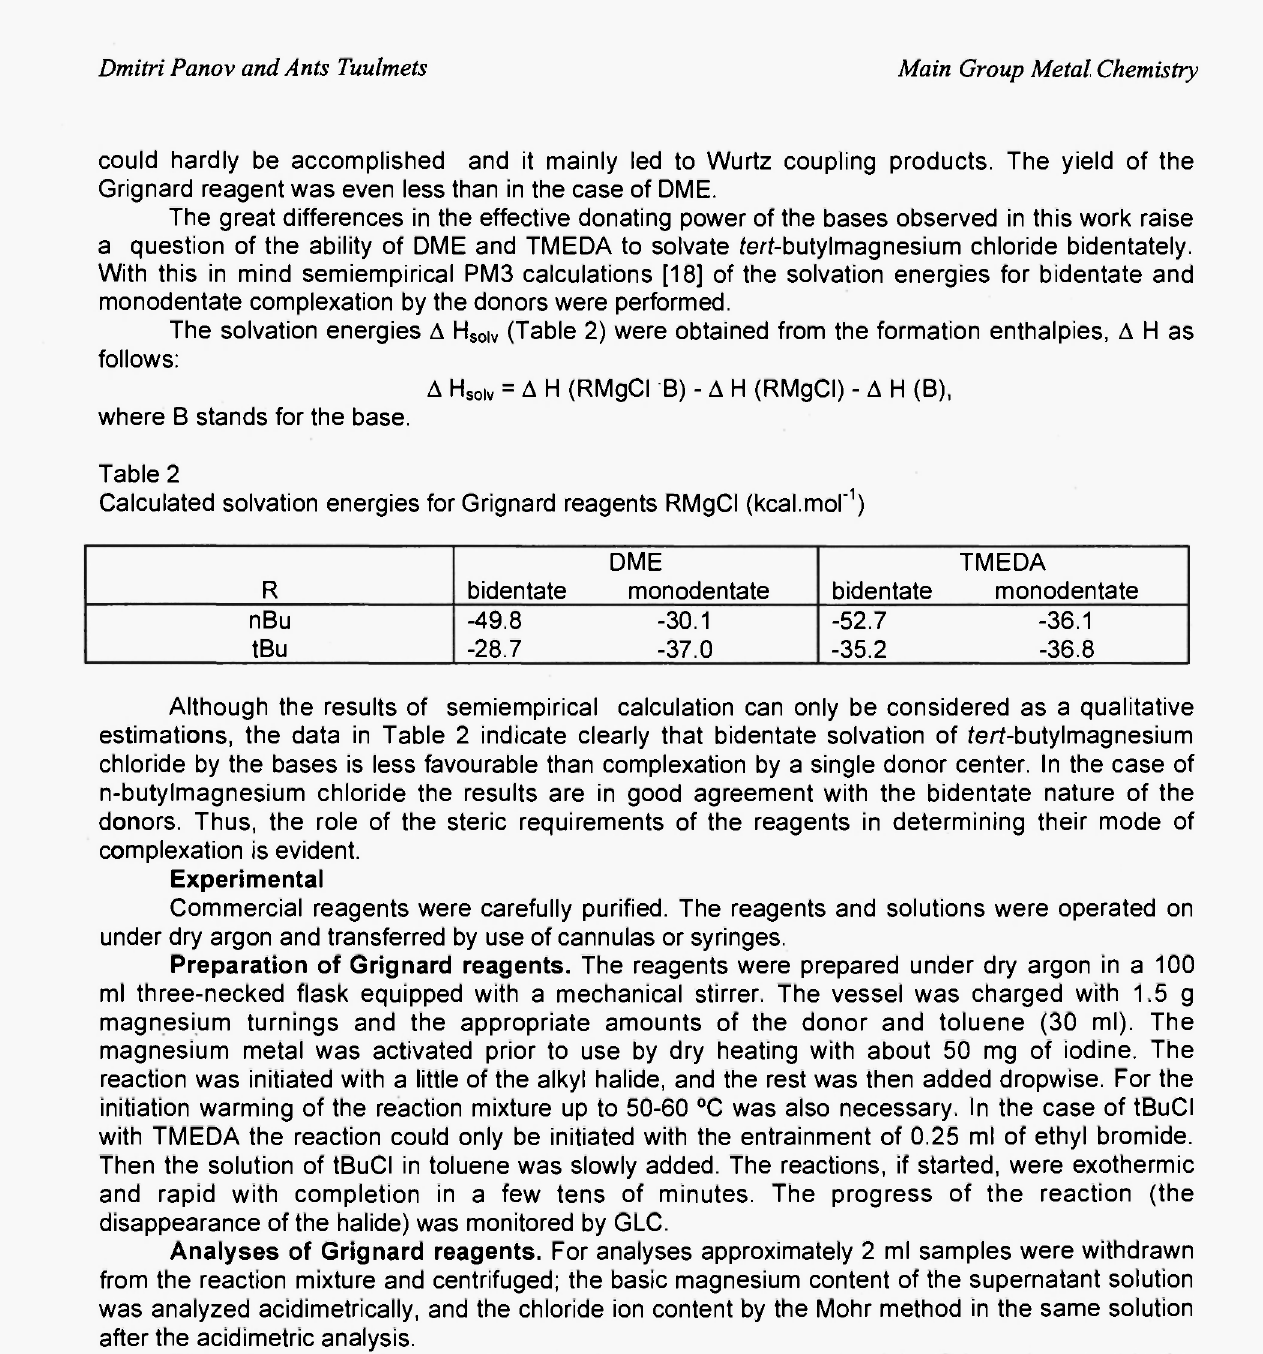
Calculated solvation energies for Grignard reagents RMgCI (kcal.mol" 1 )